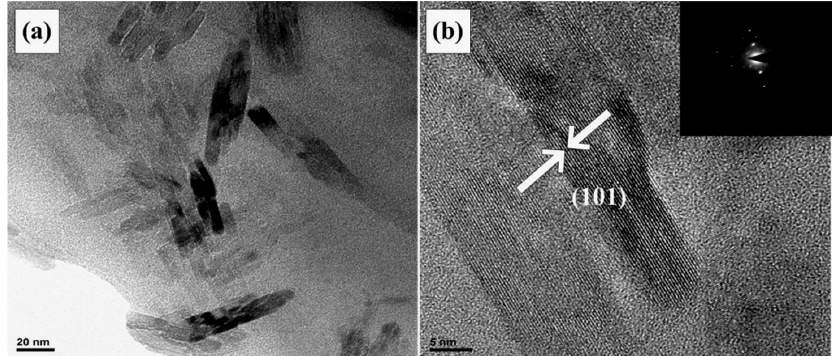
Figure 4. ( a ) TEM image; ( b ) HRTEM image of the web ‐ like TiO 2 thin film sample.